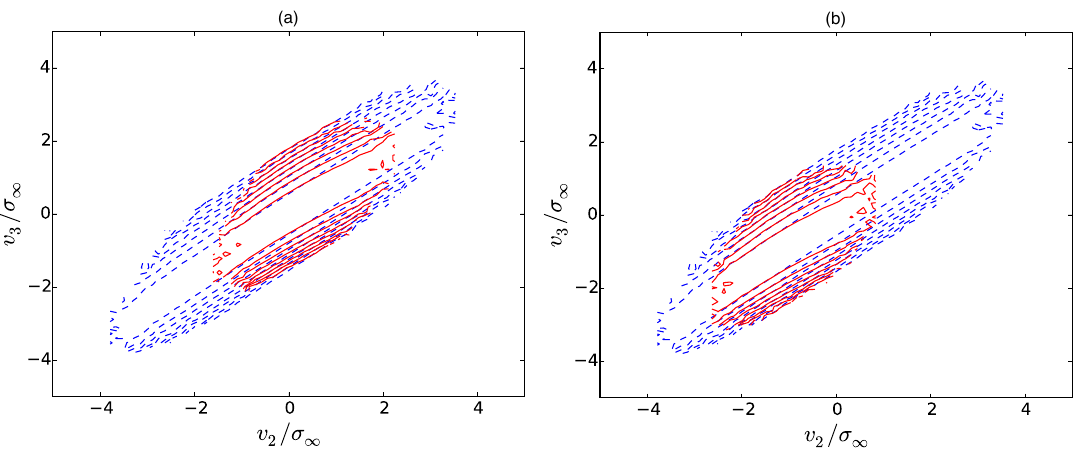
Figure 21. ( a ) examination of the Markov property (28) from DNS of the intermediate case for ∆ r = 2.2 λ and v 1 = 0 via a logarithmic contour plot. ( b ) same as in ( a ), but for v 1 = − σ ∞ . The shape of the conditional PDF (red) does not change significantly in comparison to ( a ).